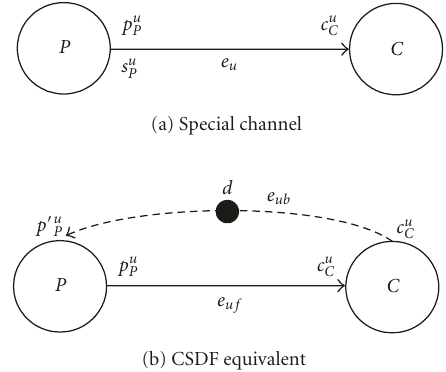
Figure 4: Partial updates between a producer P with period L P